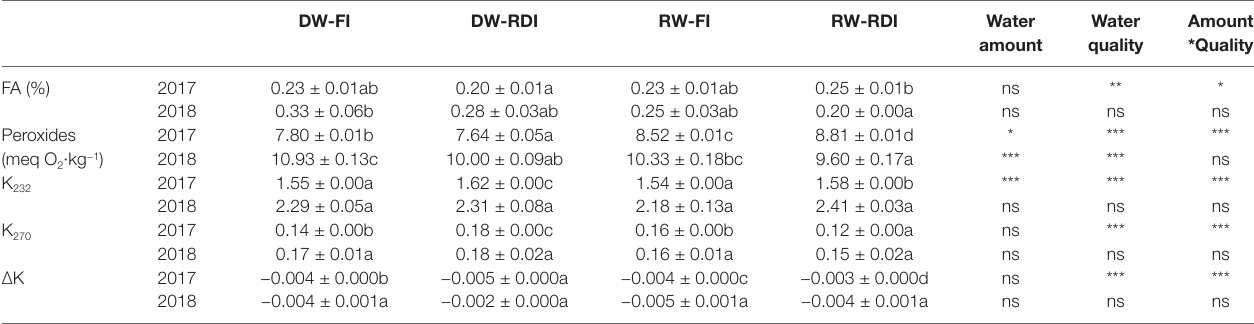
Different letters within the same row indicate significant differences among treatments for the different parameters and years according to Tukey’s test (*p < 0.005 ; **p < 0.01; ***p < 0.005). ns, not significant.